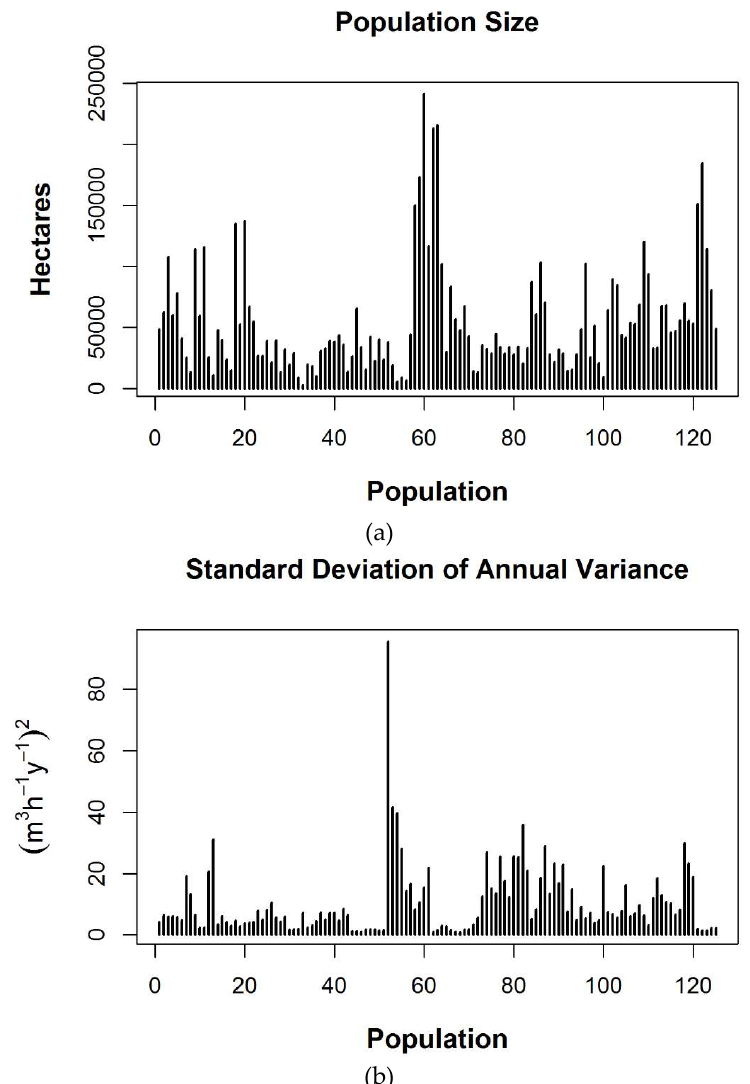
Figure 2. The size in hectares for the 125 populations ( a ), and the standard deviation of the within-population annual variance of cubic meter volume growth ( b ).